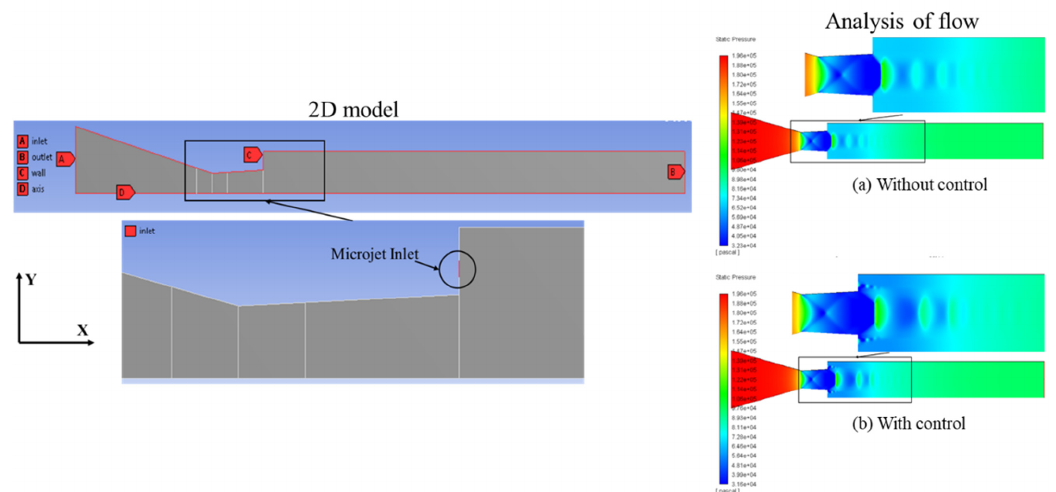
Figure 10. D nozzle with sudden expansion duct and their results. Reprinted with permission from ref. [2]. Copyright 2021 Springer.